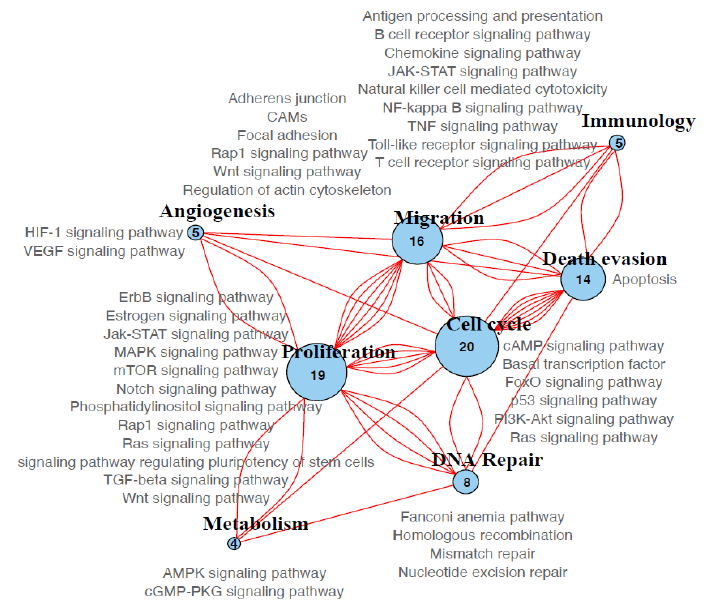
Figure 5. Global biological processes enriched in the tumors. Eight large processes of enriched pathways were detected. The size of the circle equals the number of genes associated with each process across all samples. Lines indicate that the same gene participates in the linked processes. The pathways grouped in each process are listed. The number of genes and pathways that participate in each process is indicated.